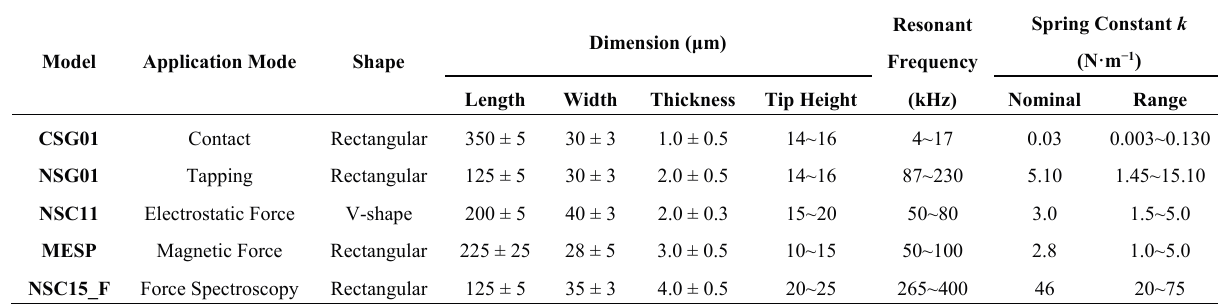
Table 1. The information of the cantilevers provided by the datasheets from the